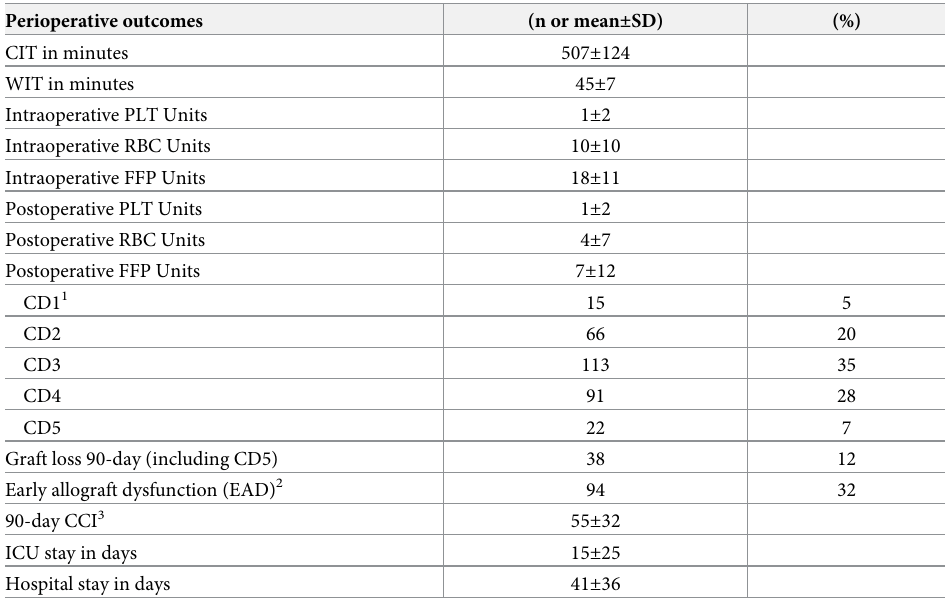
Table 3. Perioperative outcomes. Perioperative outcomes (n or mean ±